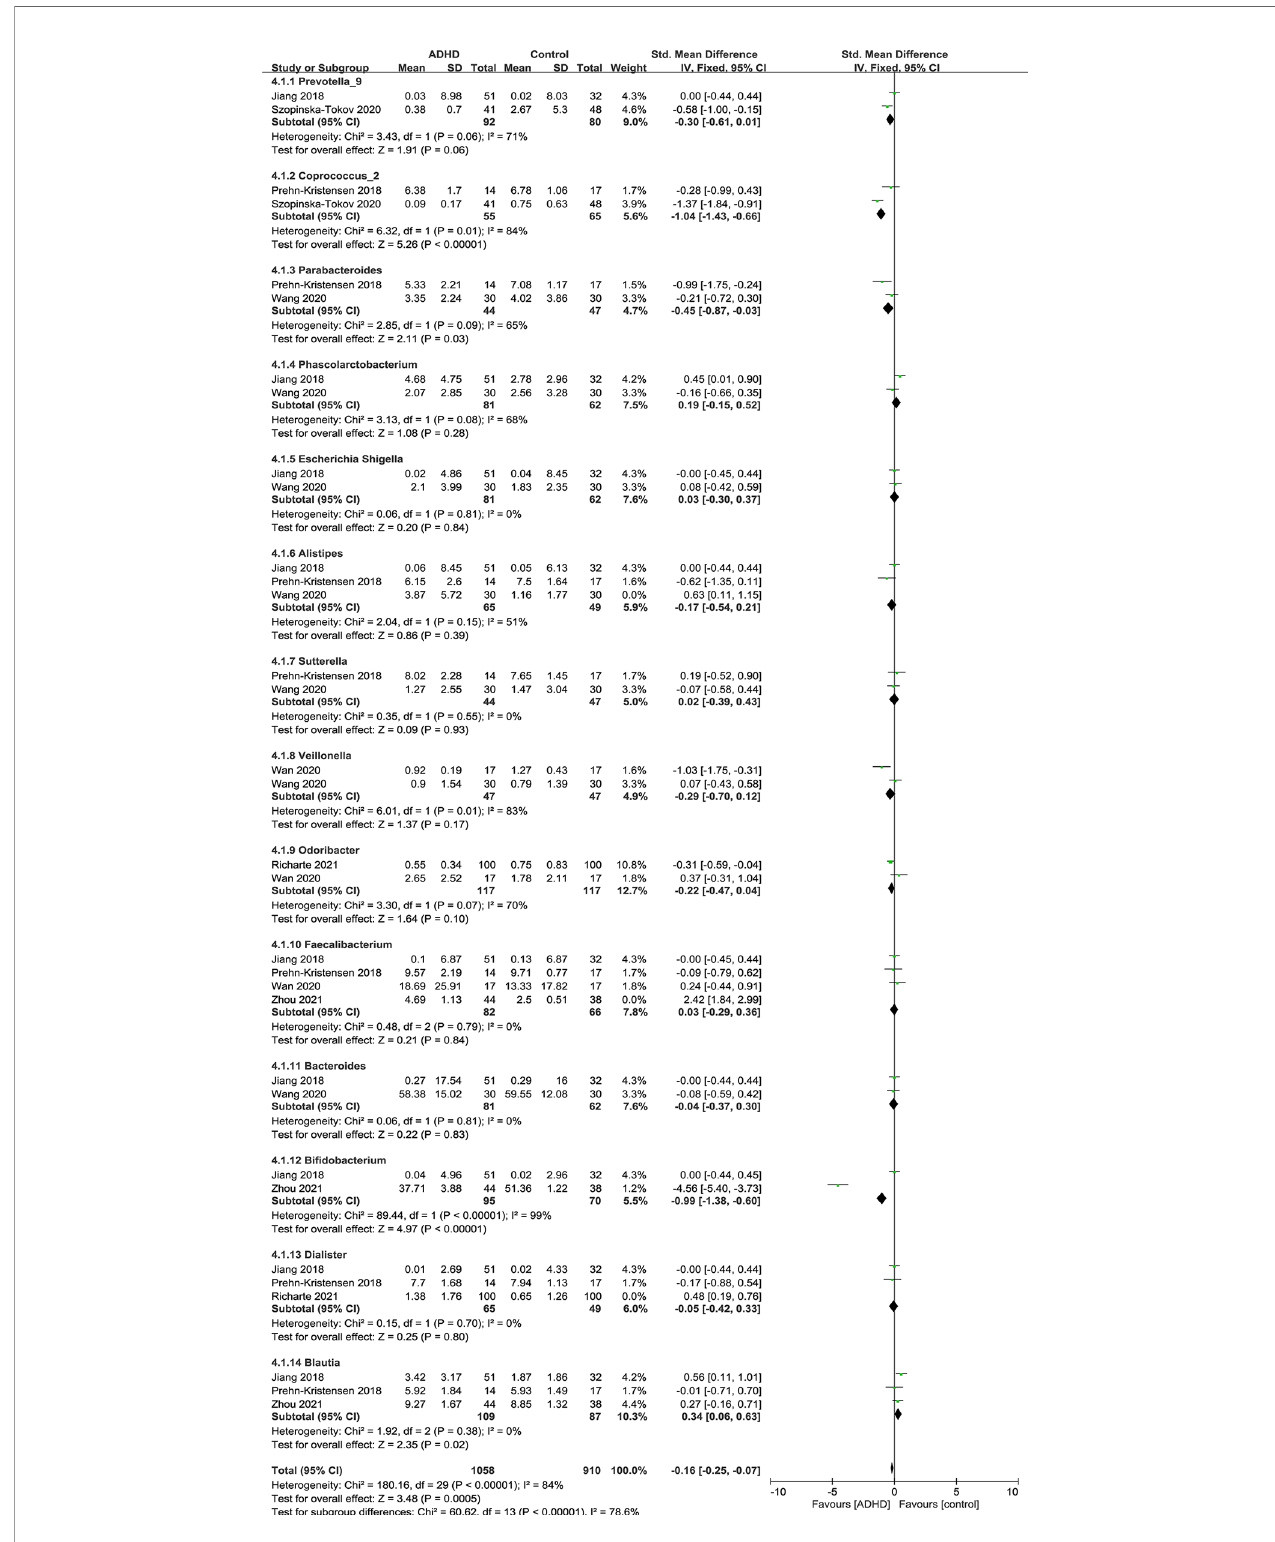
FIGURE 9 | Sensitivity analysis after removing heterogeneous studies of relative abundance of Genus in the Gut Microbiota of ADHD Compared with HCs. CI, con fi dence interval; SMD, standardized mean difference.